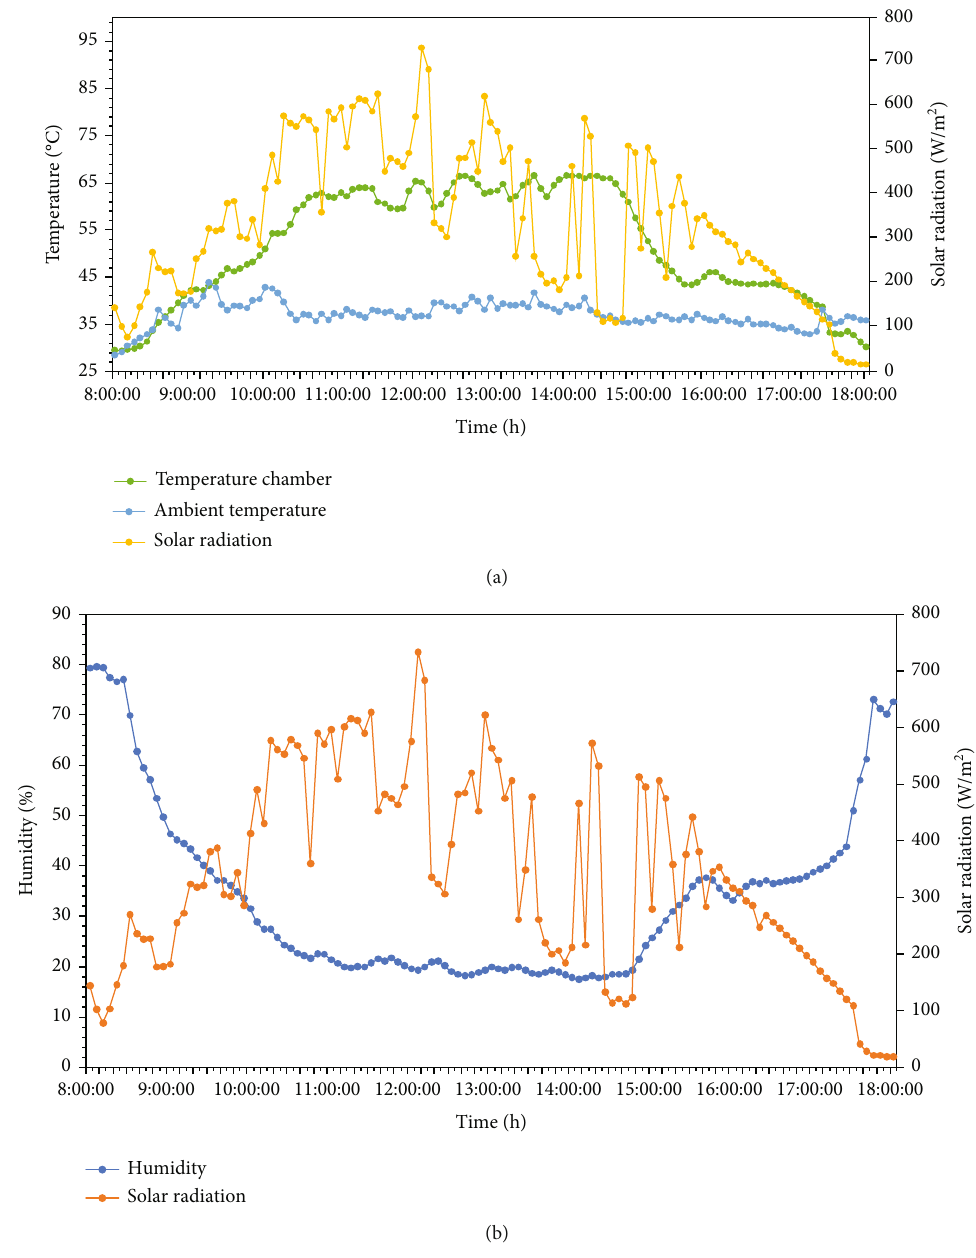
Figure 2: (a) Temperature inside the solar drying box at daytime. (b) Relative humidity inside the solar drying box at